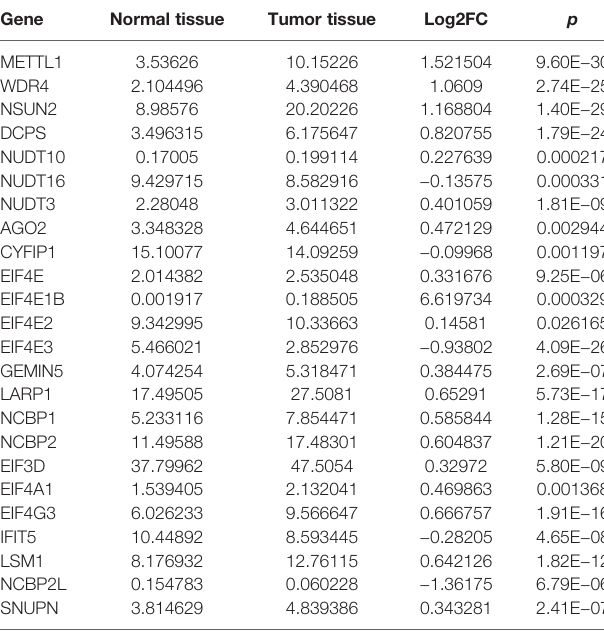
TABLE 1 | Differences in the expression of m 7 G-related genes in the TCGA- LUAD cohort. Gene Normal tissue Tumor tissue